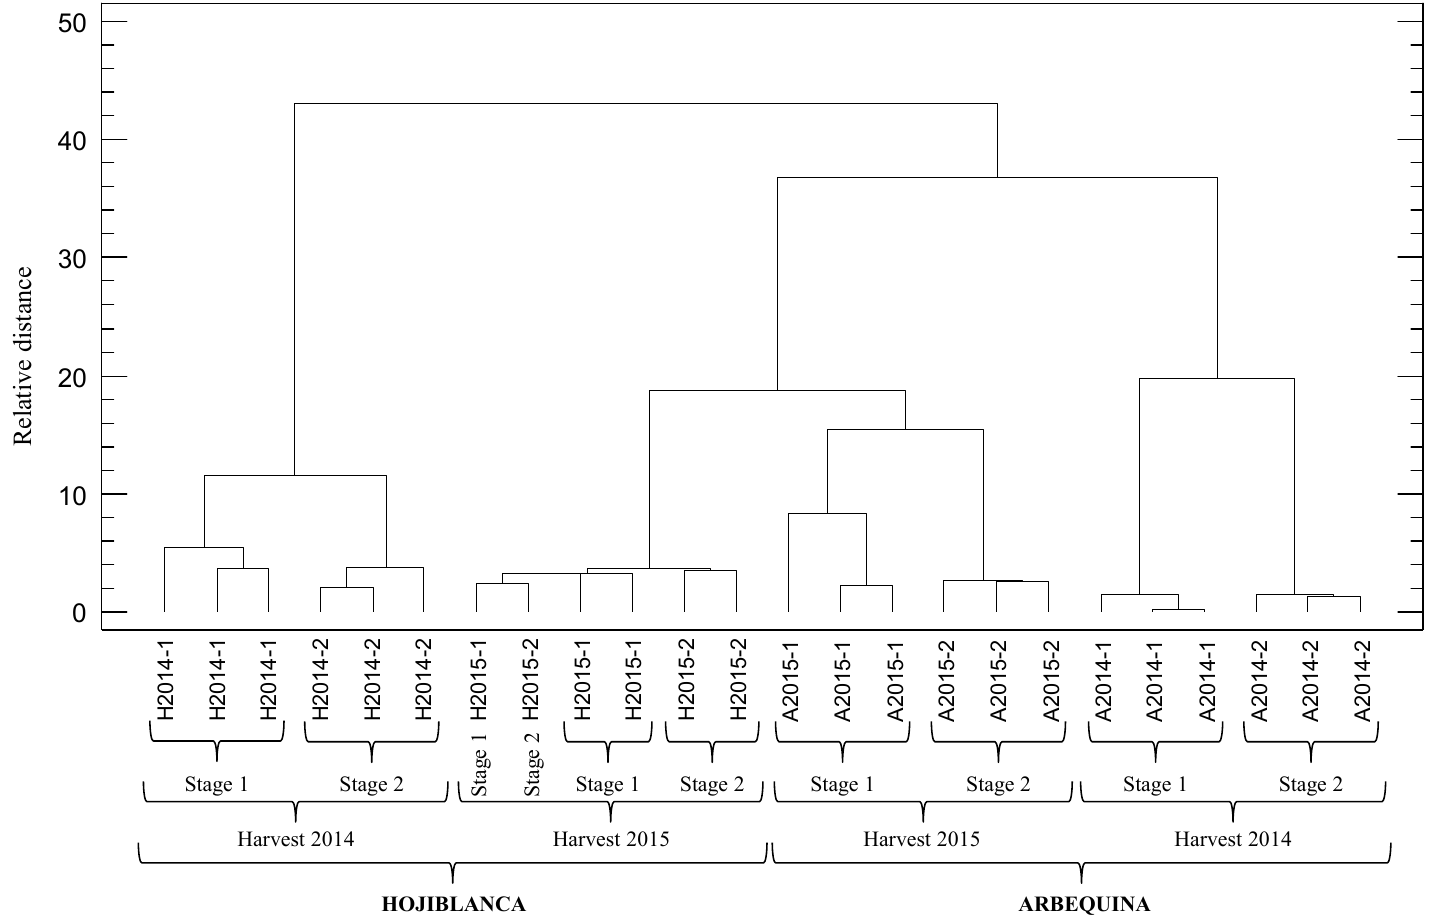
Figure 3. Dendogram generated using the nearest neighbor method and squared Euclidean distance measure, showing the conglomeration of EVOO samples obtained by clustering of all the variables analyzed in the present assay .